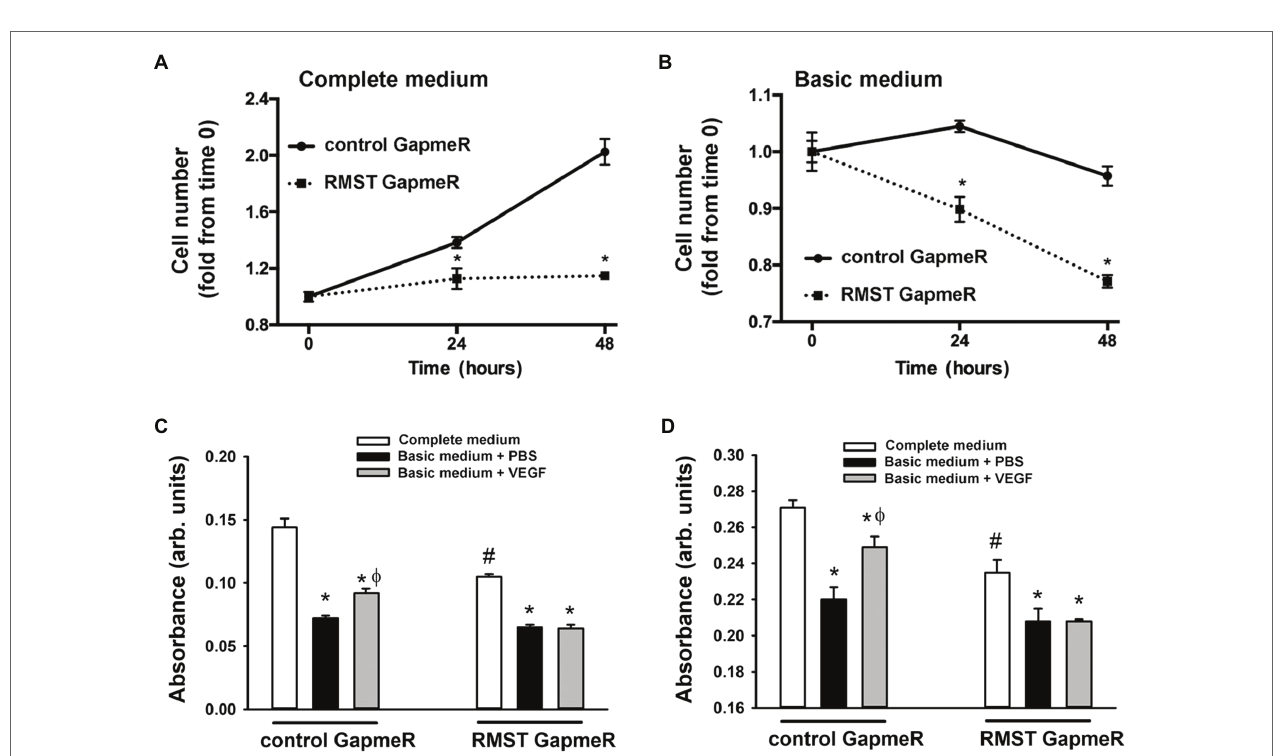
FIGURE 3 | RMST regulation of endothelial cell survival. (A,B) Hemocytometer cell counts of equal numbers of control and RMST GapmeR-transfected HUVECs maintained for 24 and 48 h in complete MCDB131medium (left) or basic MCDB131 medium (right). Values are means ± SEM, expressed as fold from time 0. * p < 0.05, compared to control GapmeR. N = 6. (C,D) Hemocytometer cell counts of equal numbers of control and RMST GapmeR-transfected HUVECs maintained for 24 h in complete medium (C,D) , basic medium containing PBS (C&D), basic medium containing VEGF (C) , or basic medium containing Ang-1 (D) . Cell survival determined by crystal violet staining. Values are means ± SEM, expressed in arbitrary units. * p < 0.05, compared to complete medium. ϕ p < 0.05, compared to PBS. # p < 0.0, compared to control GapmeR-transfected cells maintained in complete